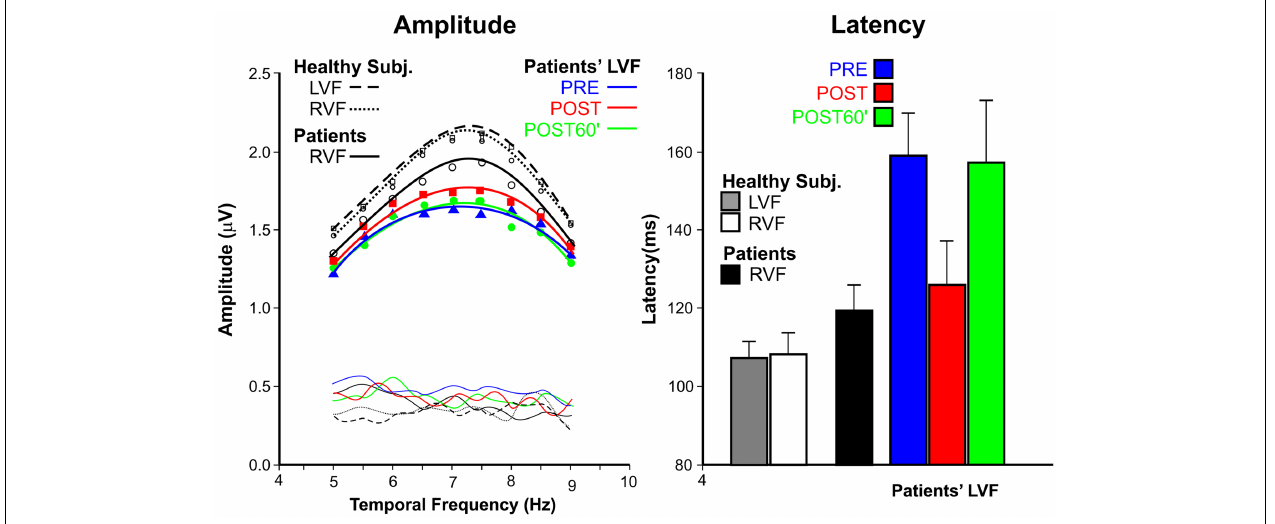
PRE, POST, and POST60 (cid:48) conditions.Thin lines without symbols represent the noise levels. Right panel: apparent latencies; as for amplitude, the data are reported in the three tested conditions.